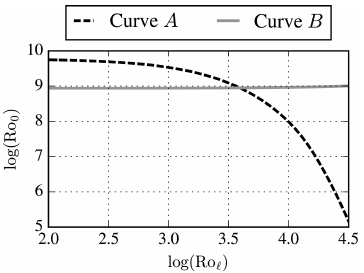
Figure A1. Example of obtaining a set of Rossby numbers from an ABL library with wind veer, Step